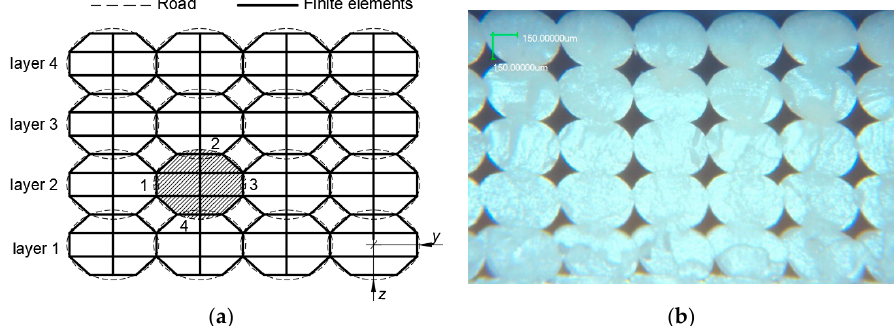
Figure 4. Mesostructure of the FDM processed part ( a ) FE modeling of regular mesostructure (diamond voids); ( b ) microscopic image of the printed part.